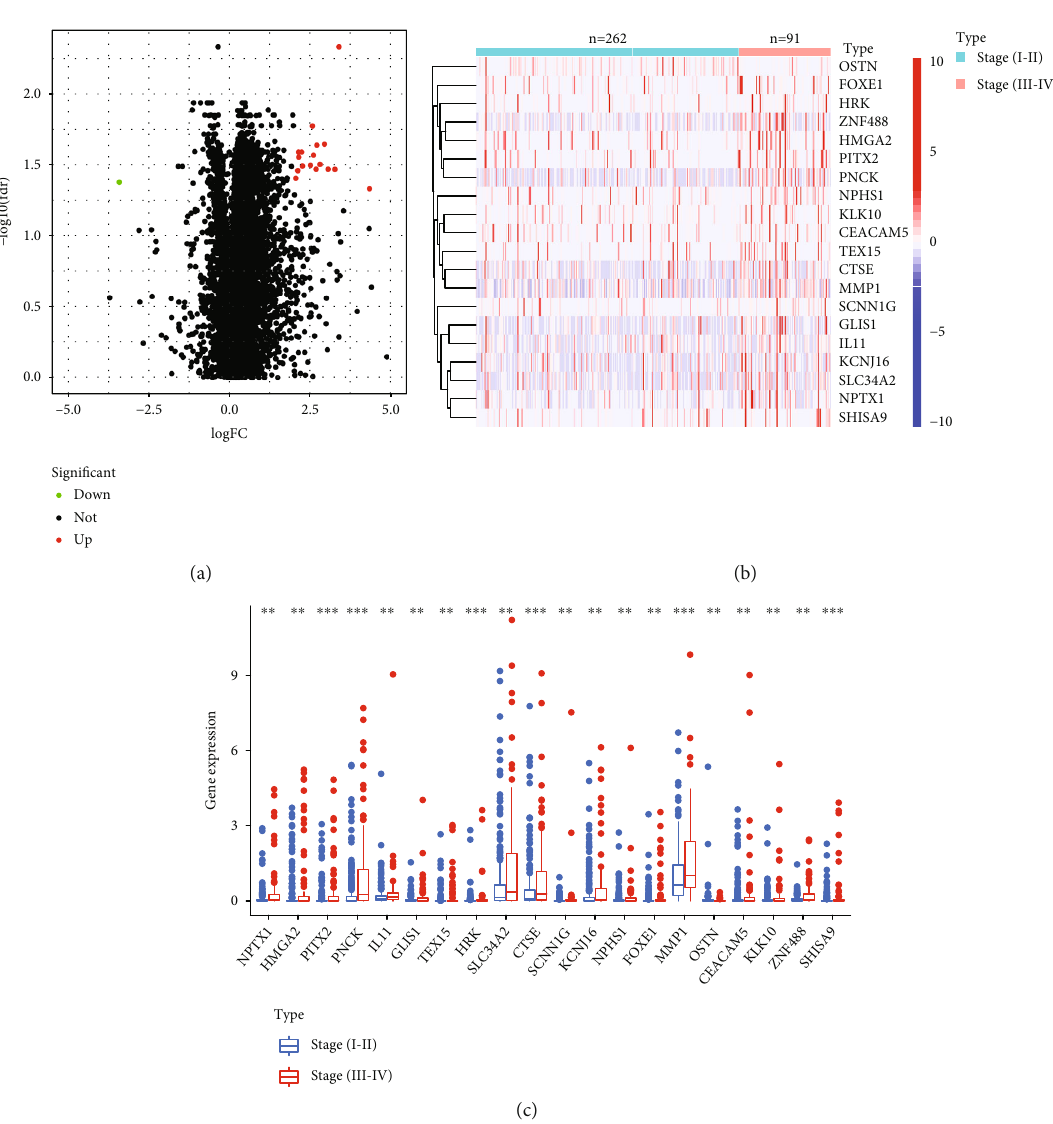
Figure 1: Identi fi cation of DEGs in HCC specimens with di ff erent clinical stages. (a) Volcano plot of DEGs in HCC specimens with di ff erent clinical stage in TCGA datasets. (b) Heat map of DEGs in the TCGA datasets. (c) Expressions of the 21 genes in HCC specimens with di ff erent clinical